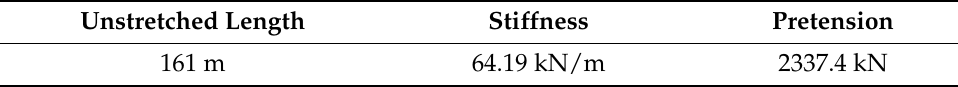
Table 2. Properties of the adopted mooring line.